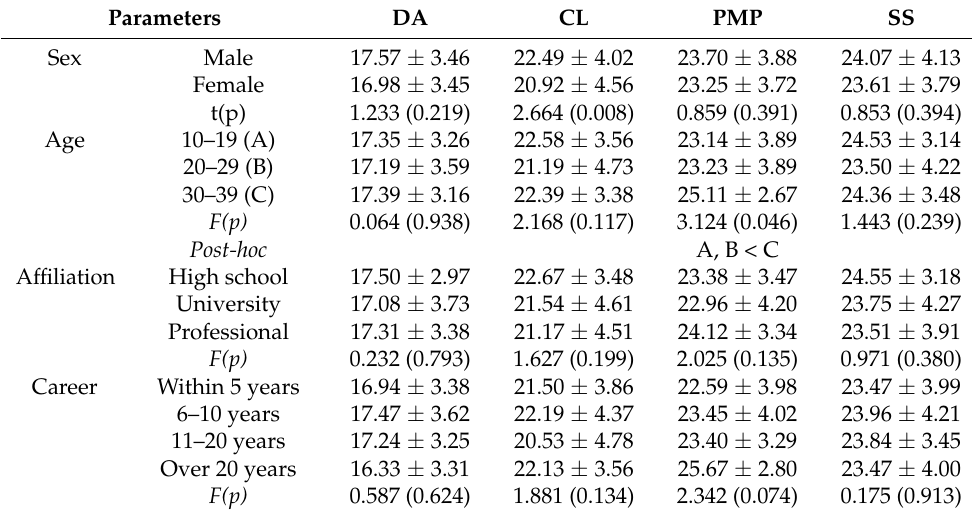
Table 2. Comparison of sports confidence ( n =